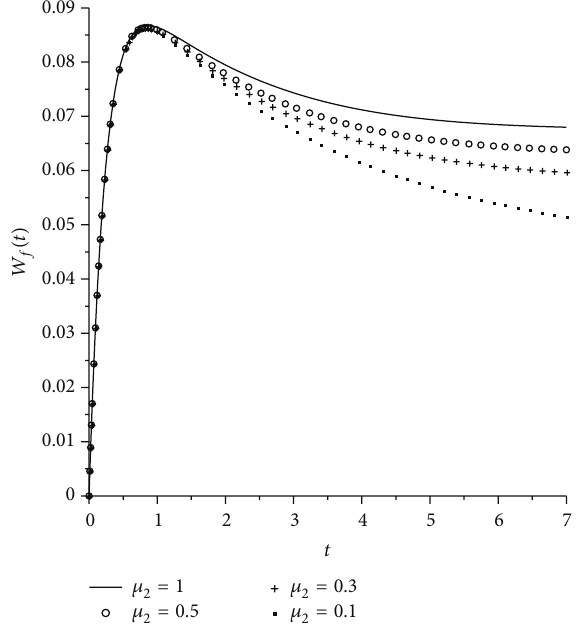
Figure 3: Instantaneous failure frequencies of the system with warning device with different 𝜇